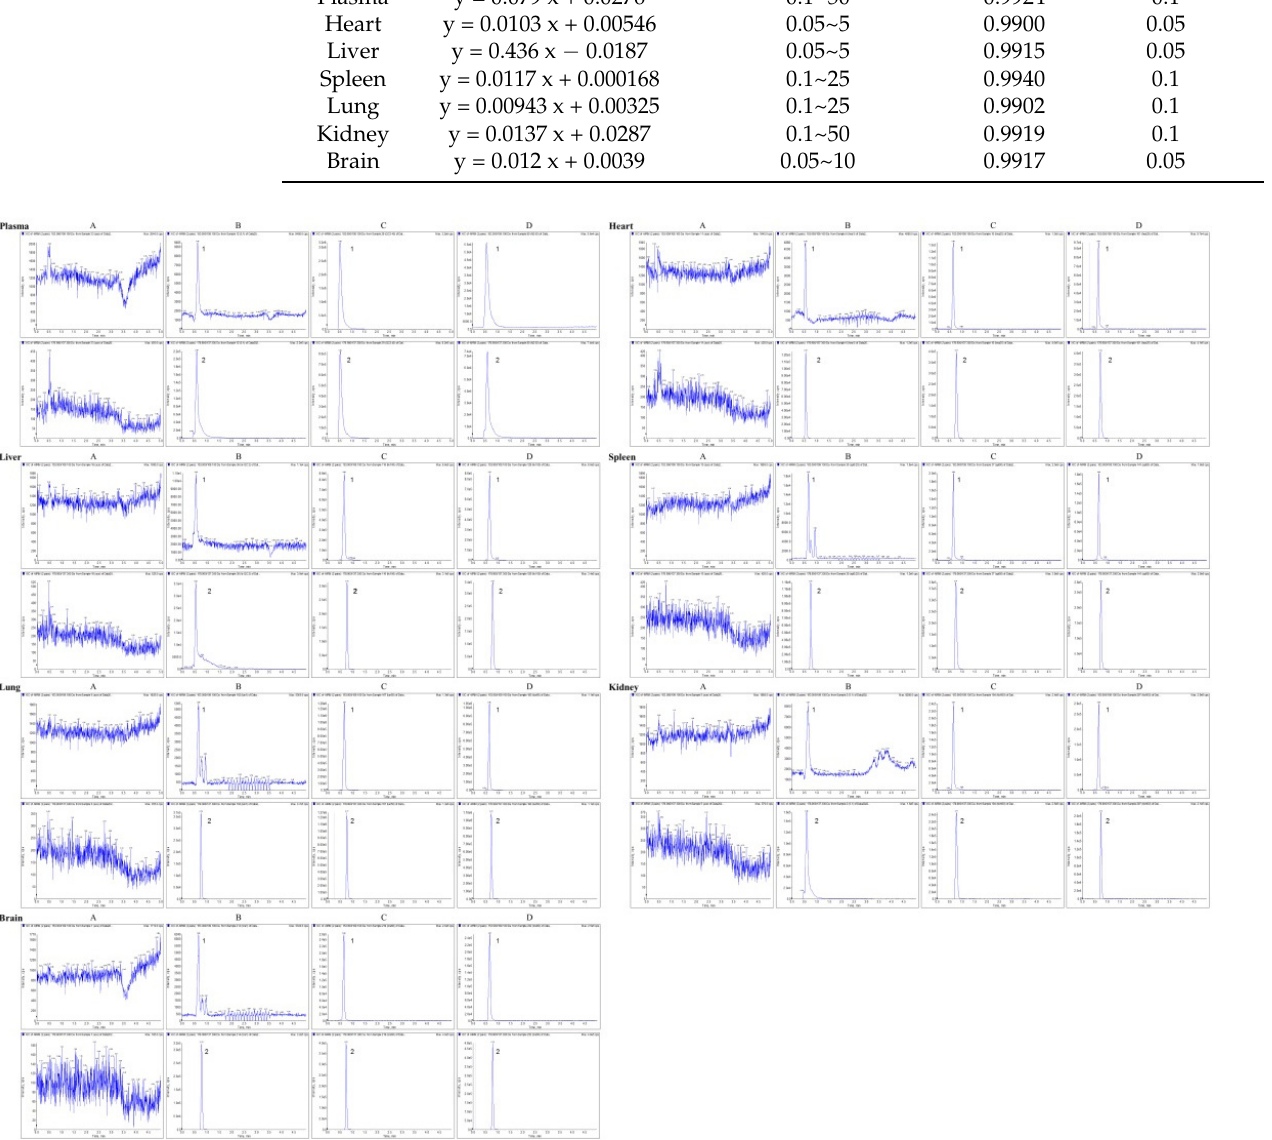
Figure 3. Typical multireaction monitoring chromatograms of acipimox and internal standard. ( A ) a blank plasma or tissue homogenate; ( B ) a blank plasma or tissue homogenate spiked with acipimox at LLOQ level (the concentrations shown in Table 2) and IS of 5 µ g/mL; ( C ) a blank plasma or tissue homogenate spiked with acipimox (plasma: 25 µ g/mL; heart, liver: 1 µ g/mL; spleen, kidney, brain: 5 µ g/mL; lung: 10 µ g/mL) and IS (5 µ g/mL); ( D ) a plasma or tissue homogenate sample collected 0.5 h after drug administration. 1: acipimox; 2: IS. Table 2. Standard curves of acipimox in plasma and tissue of rats.